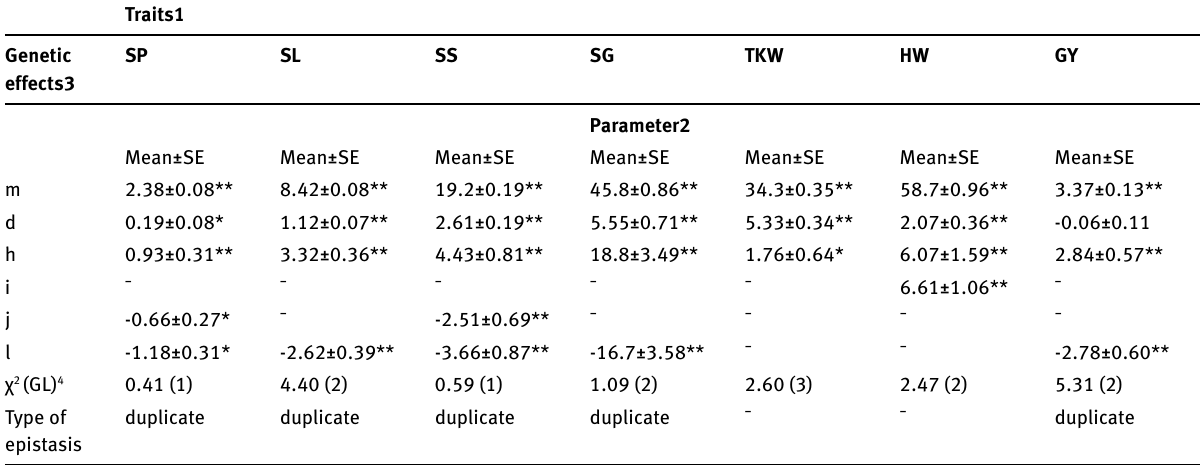
Table 2: The estimates of gene effects for quantitative traits in CIMMYT 820 x Don Santiago INTA x triticale cross